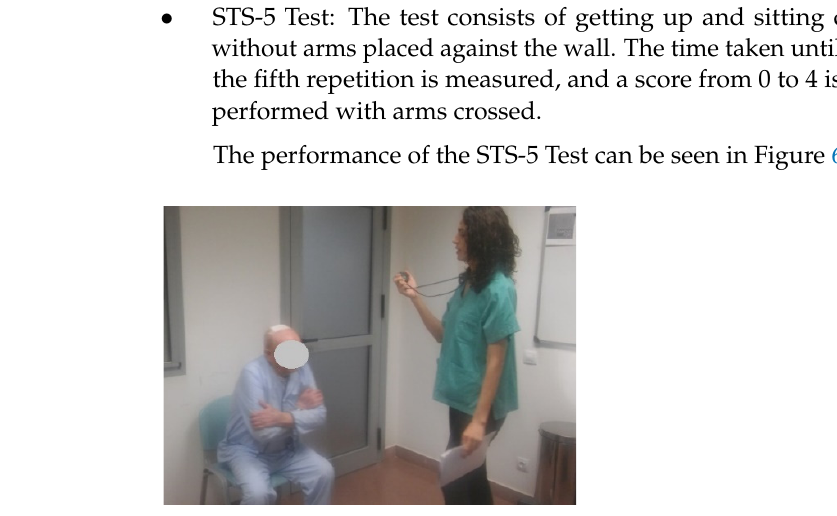
Figure 5. Walking Test at Normal Speed Over 4 Metres (reproduced with permission from Erika Meléndez-Oliva 2020) [43].